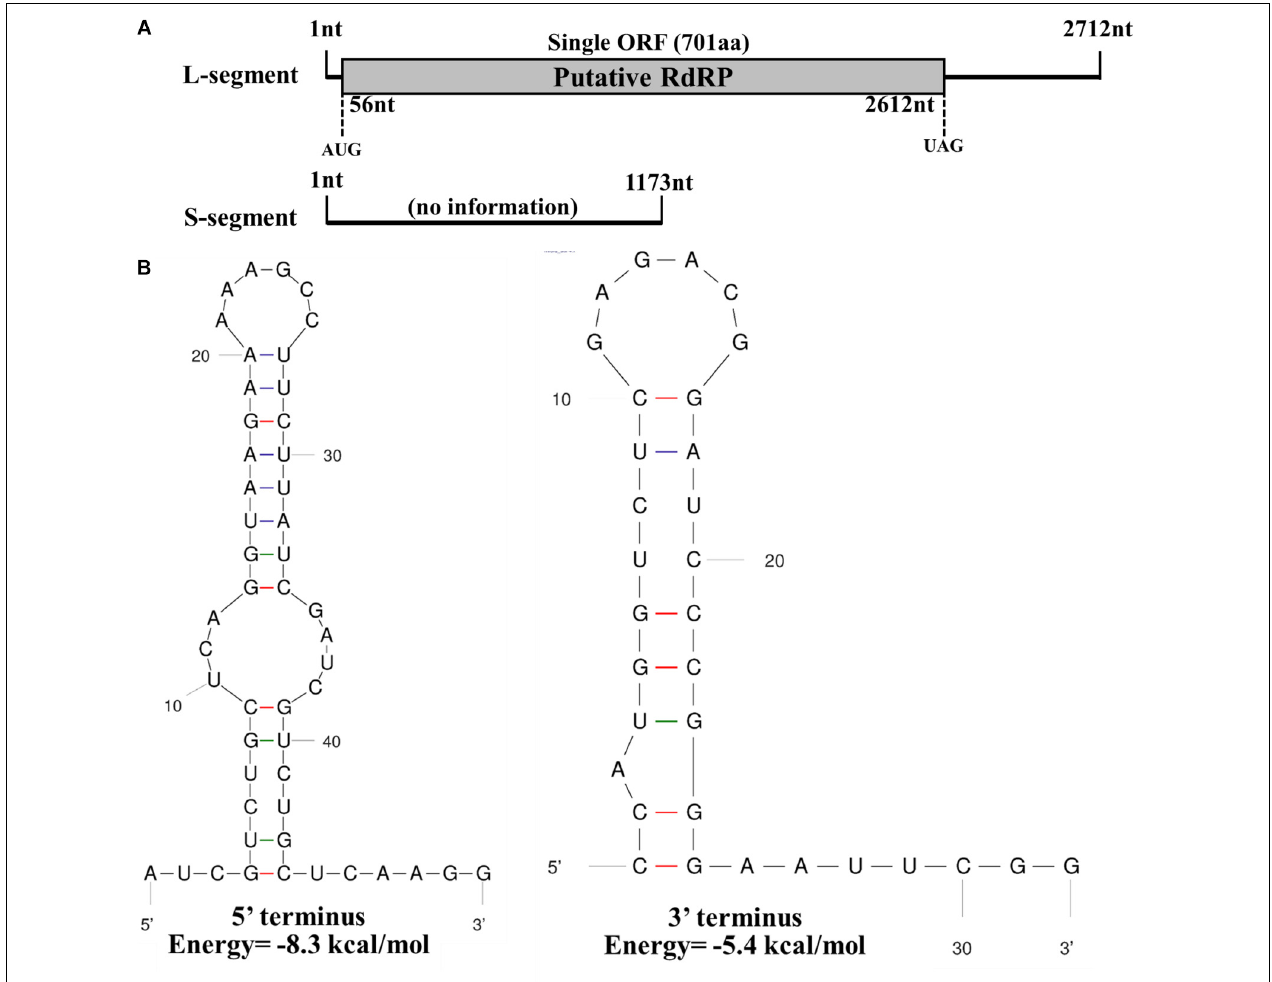
FIGURE 2 | Genomic organization and terminal structure of Fusarium oxysporum ourmia-like virus 1 (FoOuLV1). (A) Schematic representation of the putative genomic organization of FoOuLV1. The open reading frame (ORF) shown as a gray box (56–2,162 nt) was putatively encoding the RNA-dependent-RNA polymerase (RdRp) domain. (B) Potential secondary structures of the 5 (cid:48) - (left) and 3 (cid:48) -termini (right) of the L fragment of